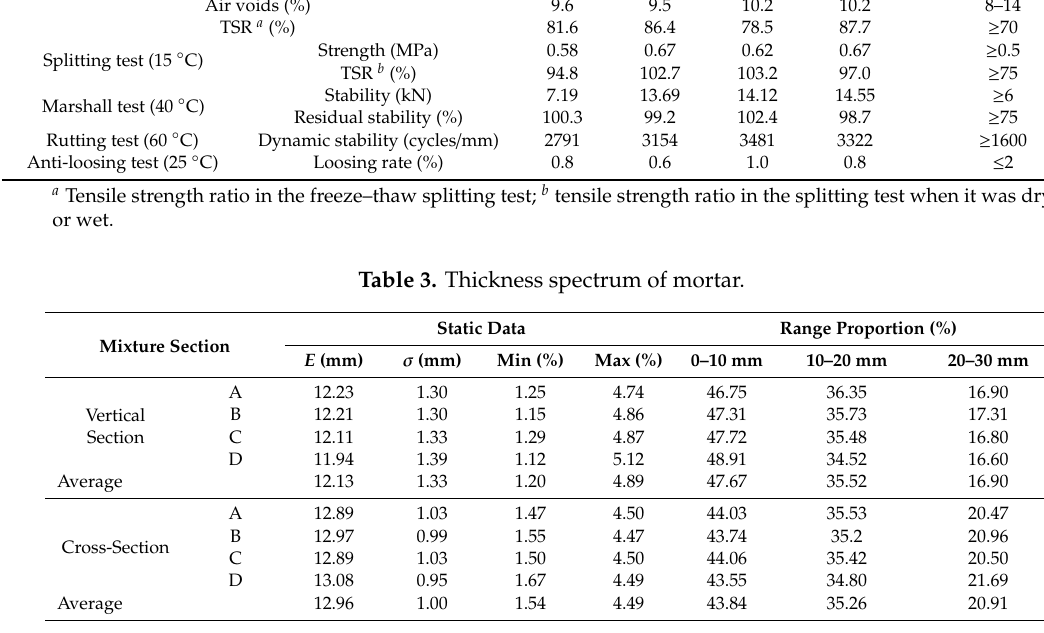
Table 3. Thickness spectrum of mortar.